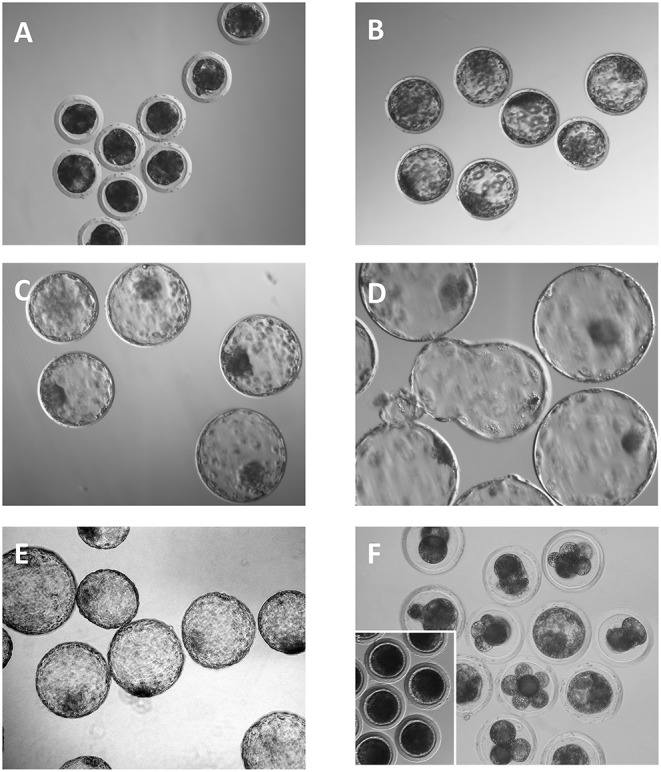
Embryos collected 6 days after the onset of estrus. (A) Compacted morulae. (B) Full blastocysts. (C–E) Expanded, hatching and hatched blastocysts, respectively. (F) Degenerated embryos. Note that most of the embryos have a developmental stage that is inappropriate for the day of the collection. Inset shows some unfertilized oocytes.